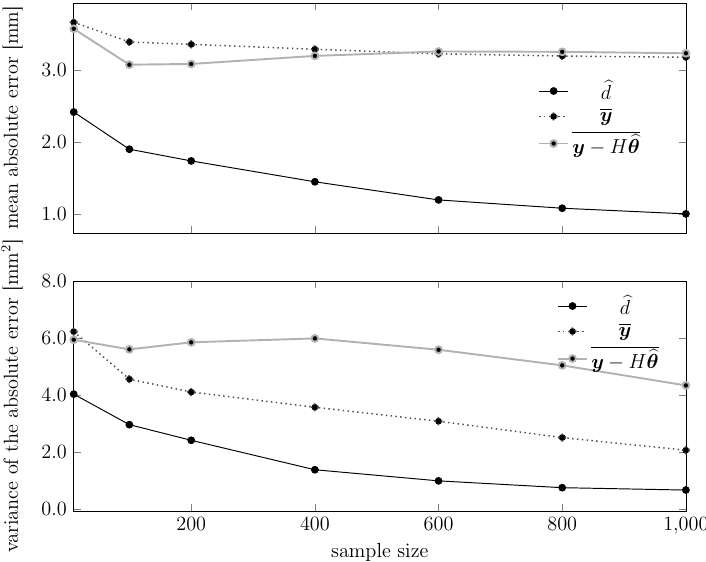
Figure 19. Dependency of the statistical moments of the absolute error of the various estimators on the test sample size. The upper plot shows the mean absolute error, while the lower plot shows the variance of the absolute error. In these experiments, the temperature of the device ranged between 24.8 °C and 28.8